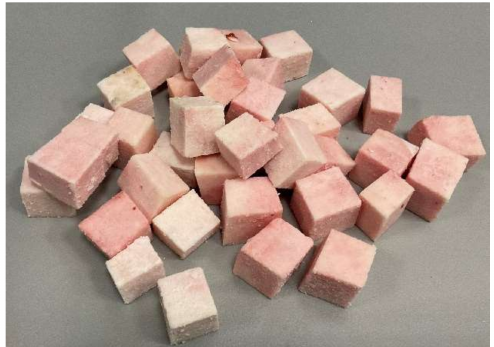
Figure 1. Fresh and clean camel bone dissected into cubes (2 cm × 2 cm × 2